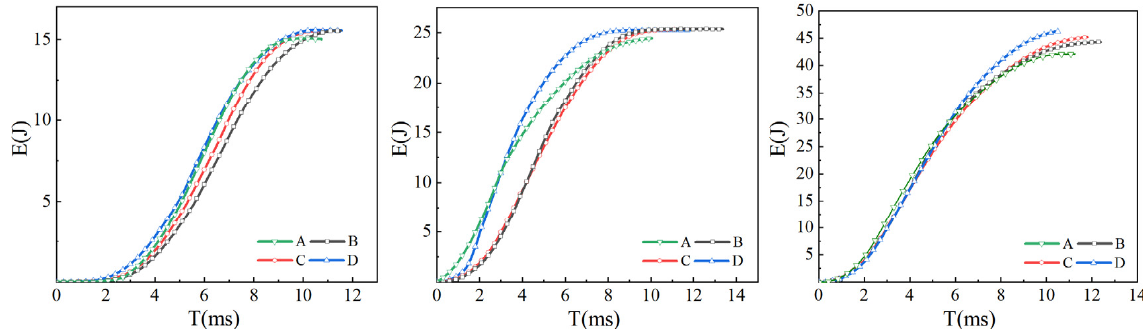
Figure 14. Impact energy absorption curve of laminate.